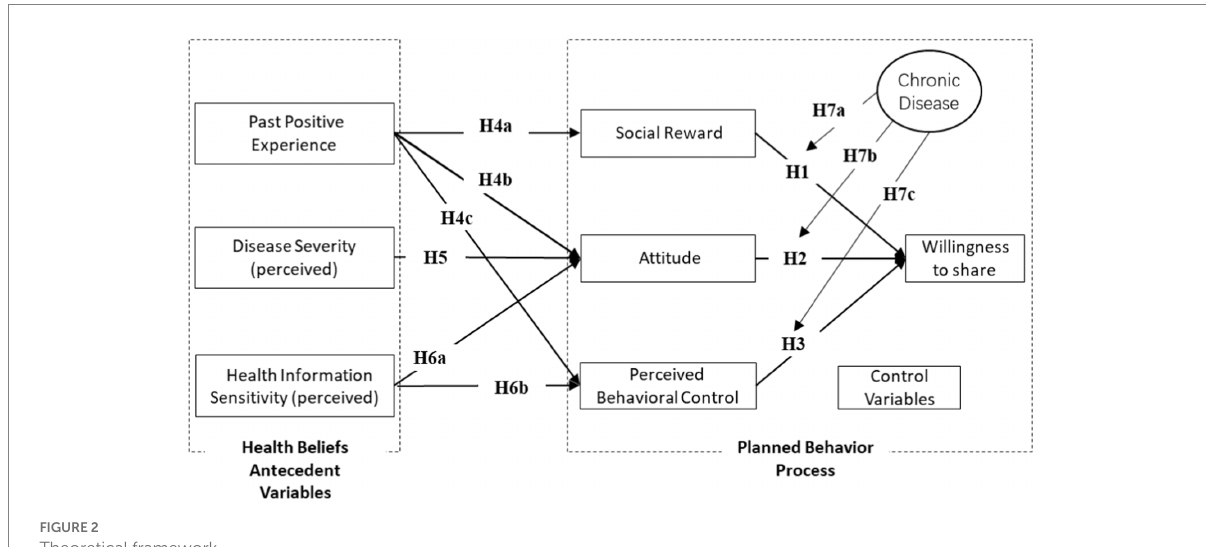
FIGURE 2 Theoretical